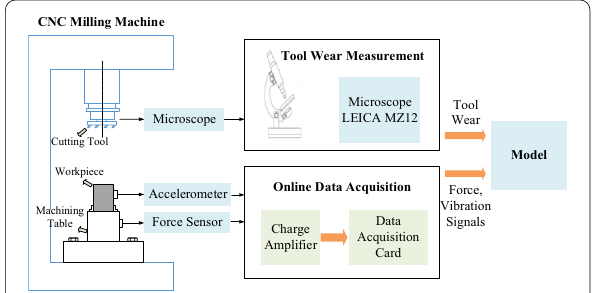
Figure 8 Details of the CNC machine and the data collected system